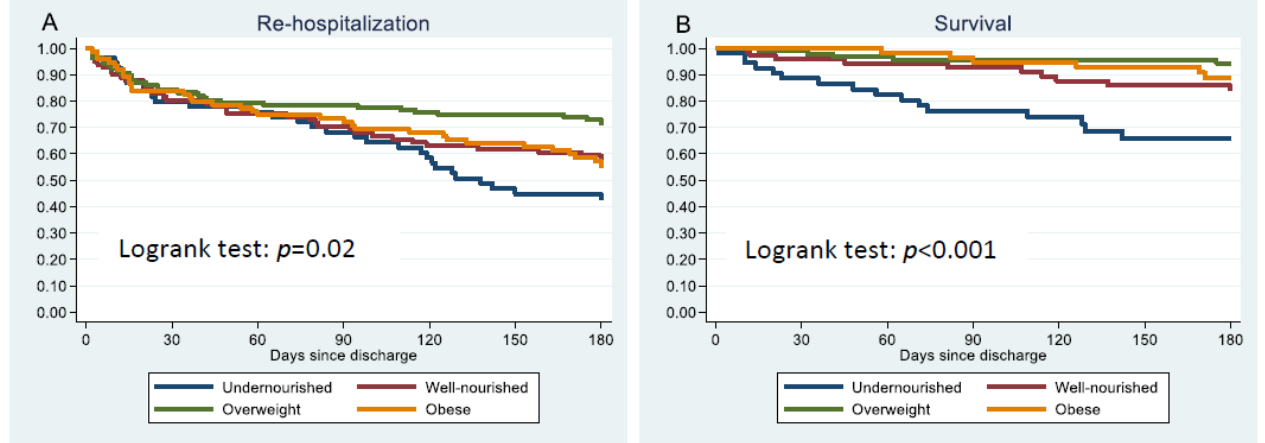
Figure 2. Kaplan-Meier estimates of probability of not having a re-hospitalization ( A ) and survival ( B ) among undernourished, well-nourished, and obese patients after discharge from hospitalization with community acquired-pneumonia. Table 3. Risk of re-hospitalization and mortality within 30, 90, and 180 days after discharge among undernourished, well-nourished (reference), overweight, and obese patients hospitalized with community-acquired